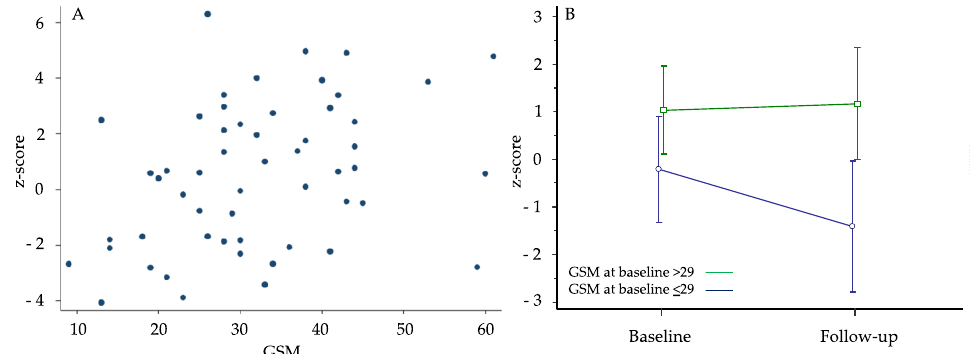
Figure 2. Panel ( A ) Spearman’s correlation between gray-scale median (GSM) and z-score at follow- up (rho: 0.392; p = 0.003). Panel ( B ) variation of composite z-score in 2 groups of participants distin- guished on the basis of the median GSM value of 29 assessed at first examination (two-factor anal- ysis of variance — ANOVA with repeated measures over time).